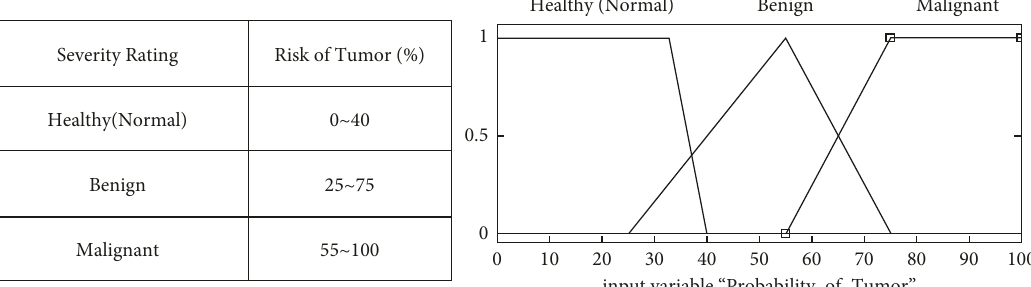
Figure 8: Input attribution function risk of tumor.